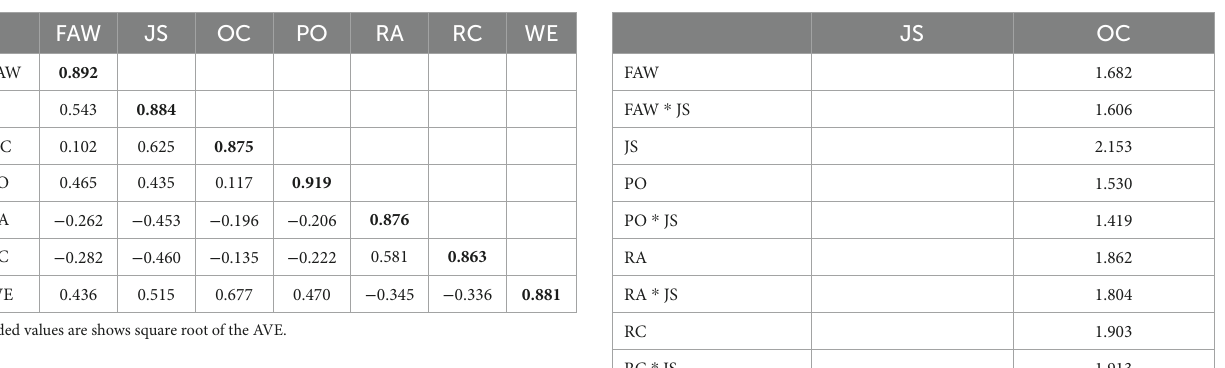
TABLE 3 Fornell Larcker criterion.